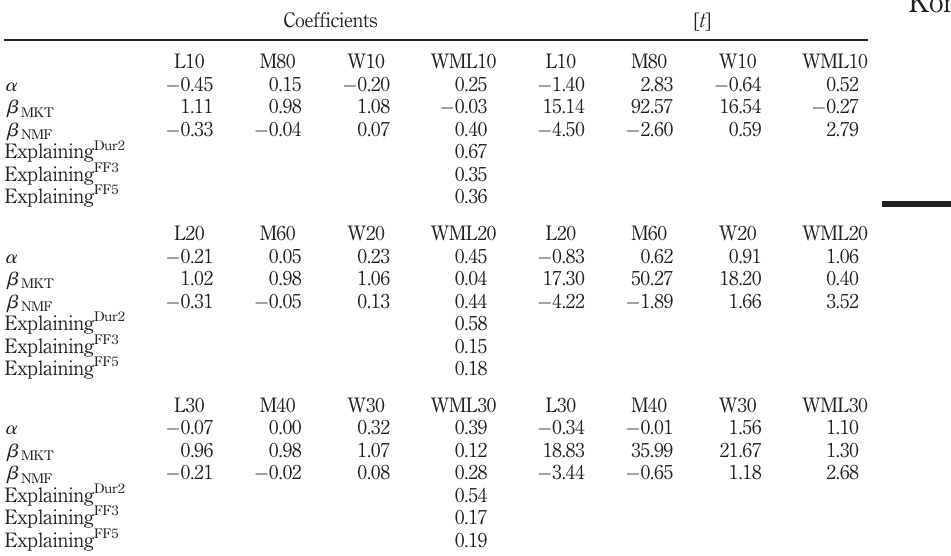
of duration factor on momentum